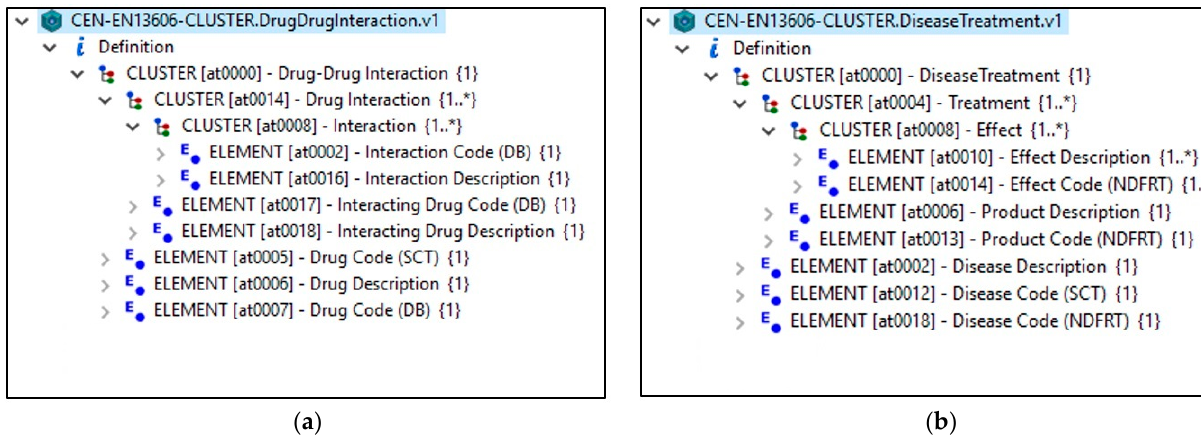
Figure 12. Augmentation archetypes’ visualization from LinkEHR. ( a ) The CEN ‐ EN13606 ‐ CLUSTER. DrugDrugInteraction.v1 augmentation archetype for the drug–drug interactions EHR augmentation. ( b ) The CEN ‐ EN13606 ‐ CLUSTER.DiseaseTreatment.v1 augmentation archetype for the disease ‐ related treatments’ EHR augmentation.